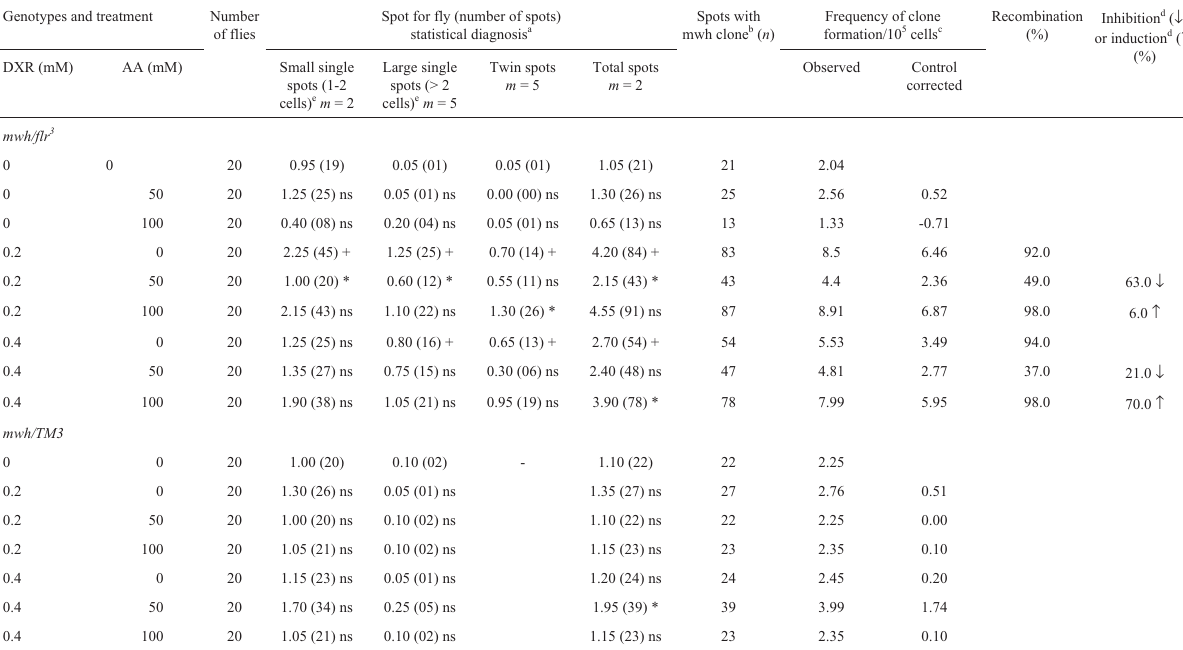
Table 2 - Summary of results obtained with the Drosophila somatic mutation and recombination test (SMART) in the marker-heterozygous (MH) and balancer-heterozygous (BH) progeny of the high bioactivation (HB) cross after chronic treatment of larvae with ascorbic acid (AA) and doxorubicin (DXR)